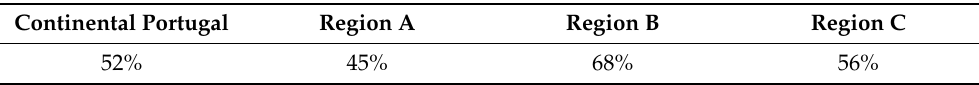
Table 4. Overall proportion of agreement (OPA) for continental Portugal and the three sub-regions A, B and